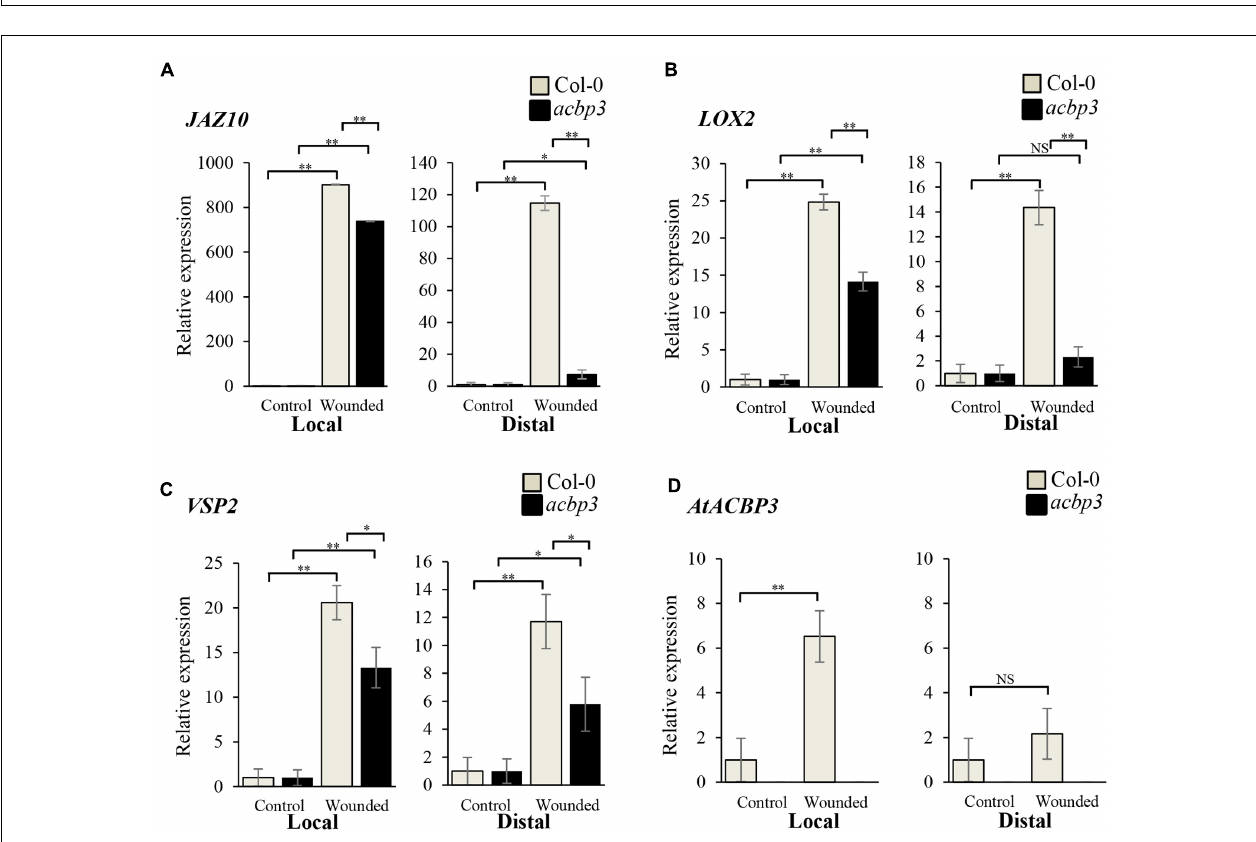
FIGURE 3 | “ ∗∗ ” indicates statistically significant difference ( P < 0.01, n = 3 by Student’s t- test) in comparison to unwounded samples collected at the same time point. Error bars represent standard deviations. (B) A representation of histochemical staining of wounded 4-week-old leaves from AtACBP3pro::GUS and vector (pBI101.3)-transformed (VC) Arabidopsis. These experiments were repeated twice with consistent results. Scale bars = 0.8 cm.